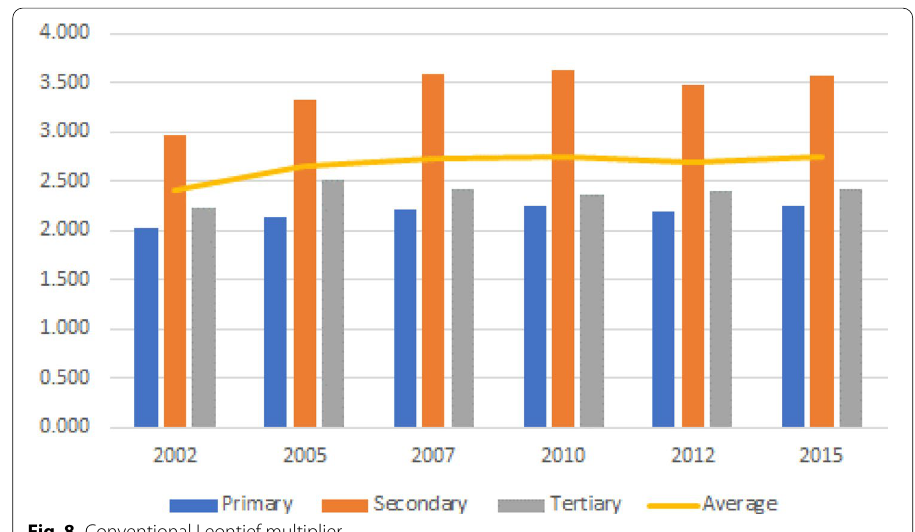
Fig. 8 Conventional Leontief